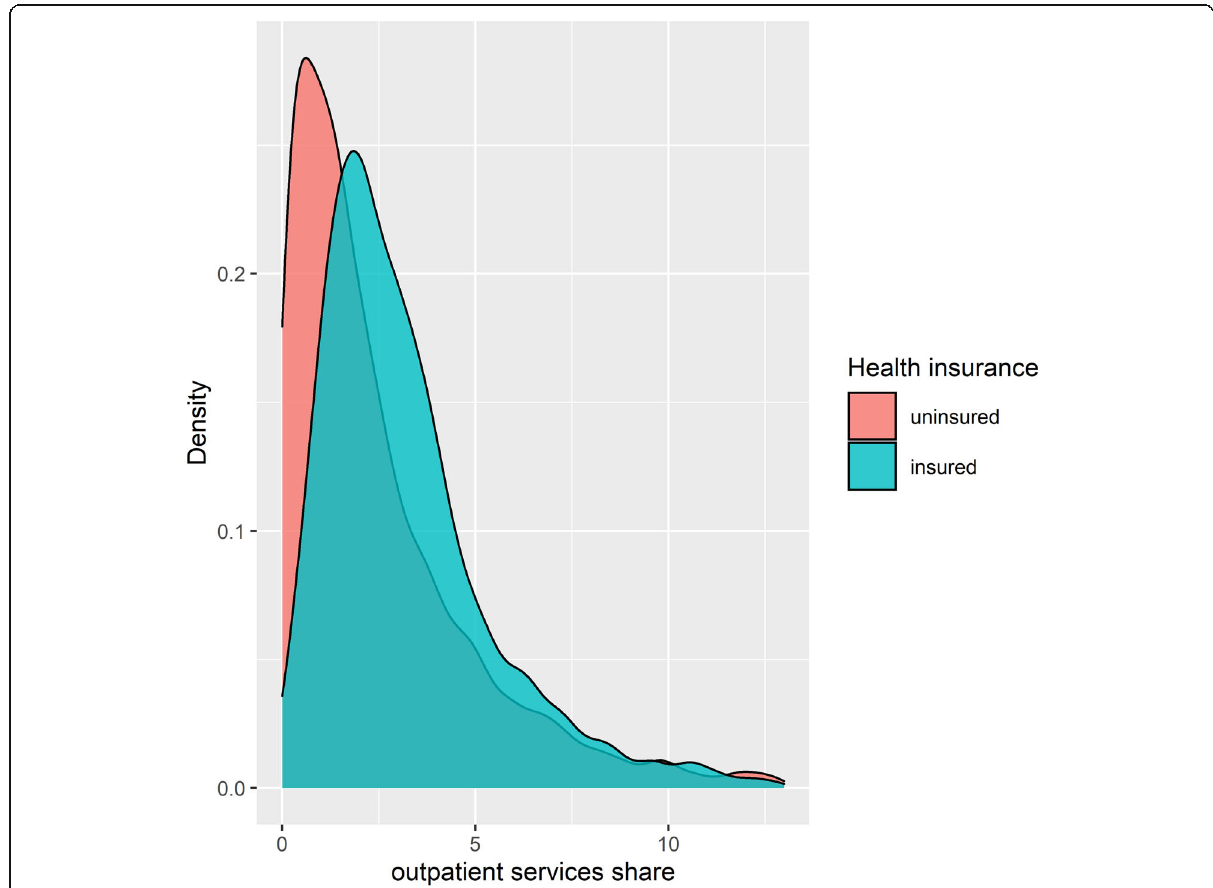
Fig. 5 Distribution of outpatient services share across health insurance